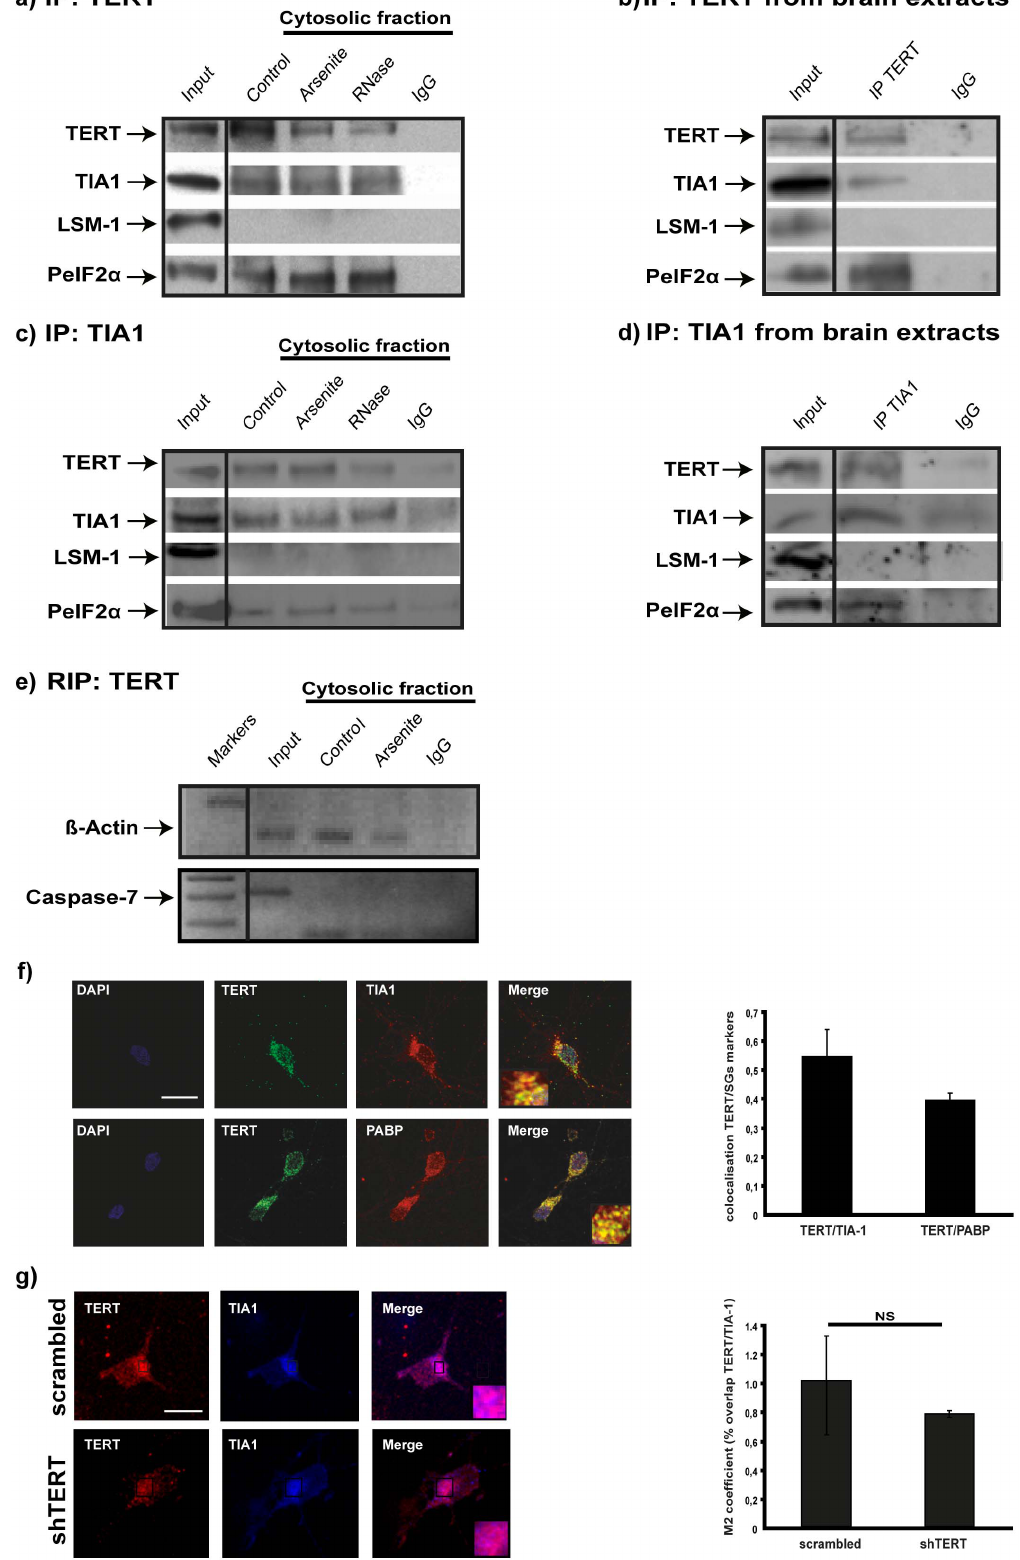
Figure 2. TERT associates to TIA1 –positive granules. a) Western blot analysis of TERT immunoprecipitated proteins in extracts from hippocampal neurons maintained in vitro for 10 DIV, under basal stress conditions (control) or stressed with arsenite. Note that the two SG markers (TIA1 and P-elF2 a ) are precipitated whereas LSM-1, a component of PBs is not. RNase treatment does not affect TERT-TIA1 binding (n=4). b) Western